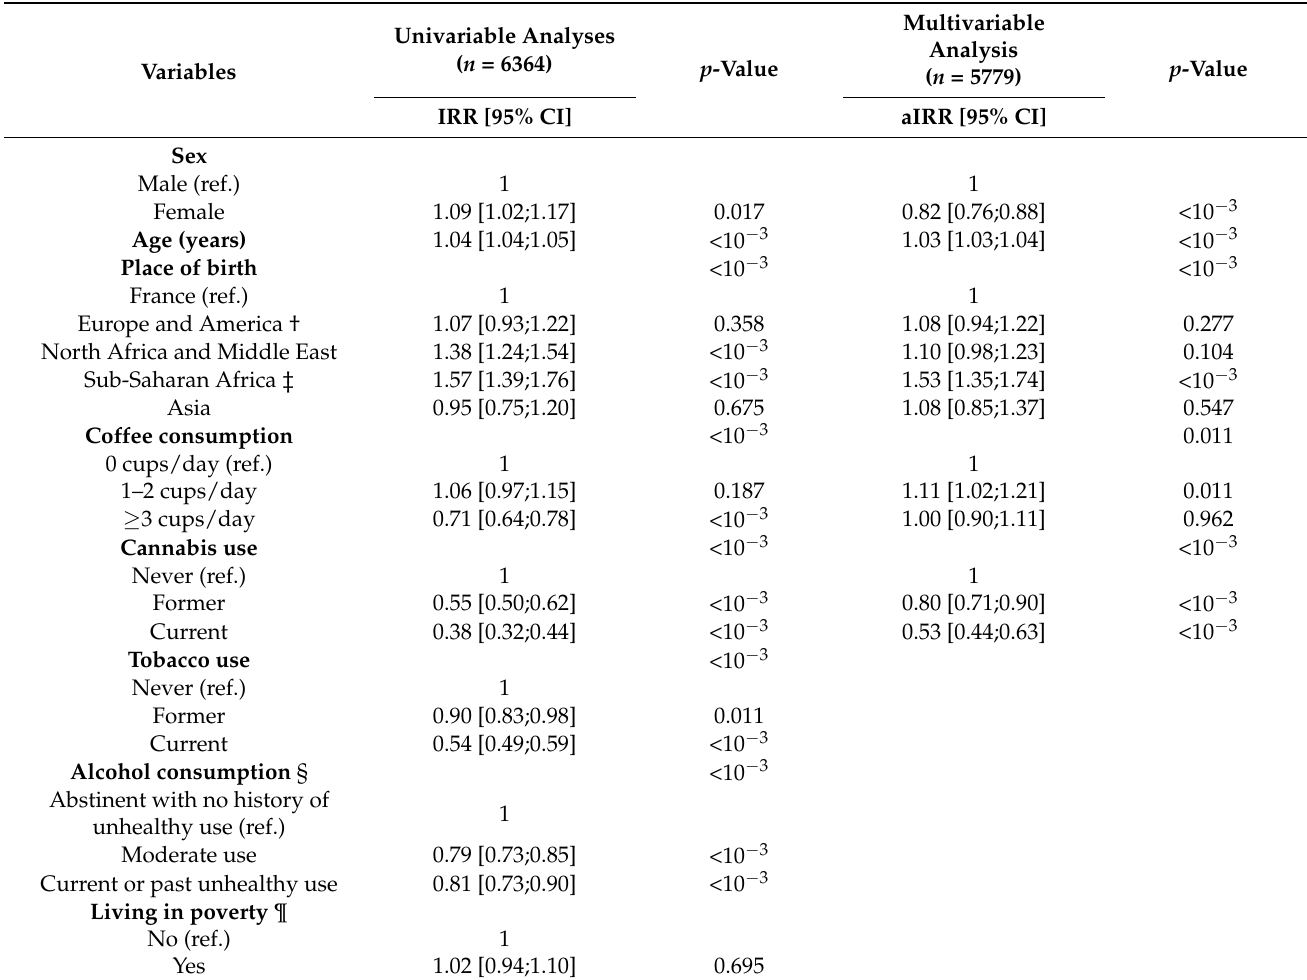
Table 3. Factors associated with the number of metabolic disorders among central obesity, dys- lipidemia, hypertension, and diabetes (univariable and multivariable negative binomial regression models, ANRS CO22 Hepather cohort, n =